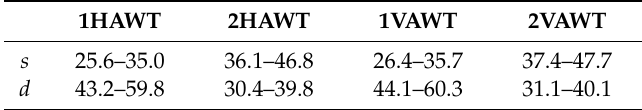
Table 6. Range for s and d factors considering the system located in